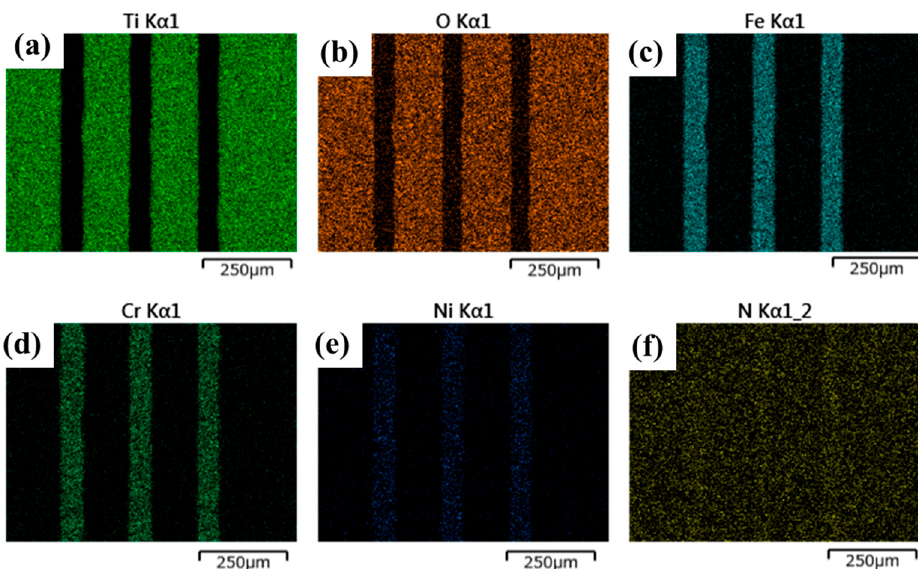
Figure 8. Element mapping analyzed by SEM–energy dispersive X-ray spectroscopy (EDX) for the nitrided AISI316 substrate. ( a ) Titanium, ( b ) oxygen, ( c ) iron, ( d ) chromium, ( e ) nickel, and ( f ) nitrogen.